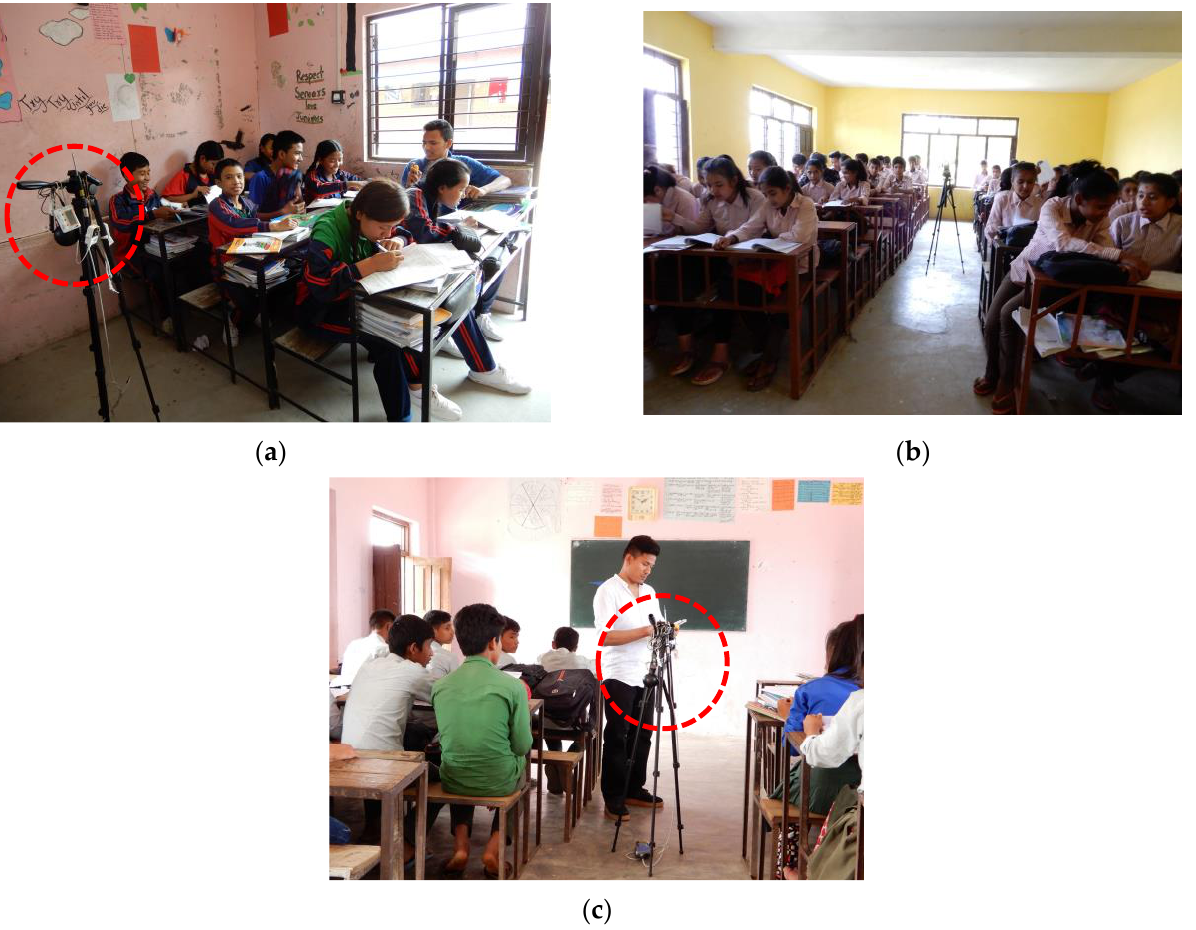
Figure 3. Internal view shows the position of digital instruments with data loggers: ( a ) S1; ( b ) S2; and ( c ) S3. Table 3. Properties of the data logger used.